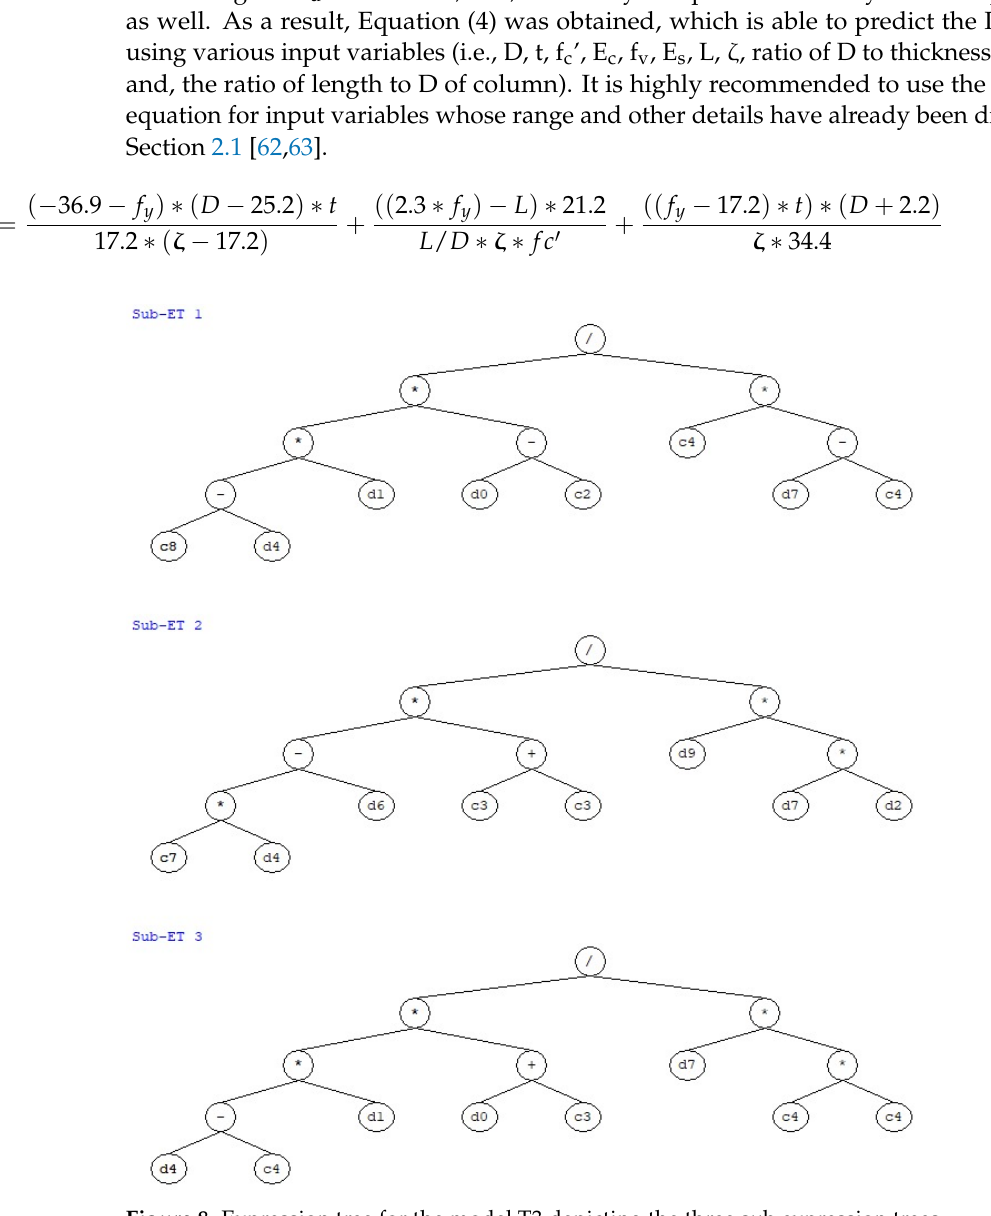
Figure 8. Expression tree for the model T3 depicting the three sub expression